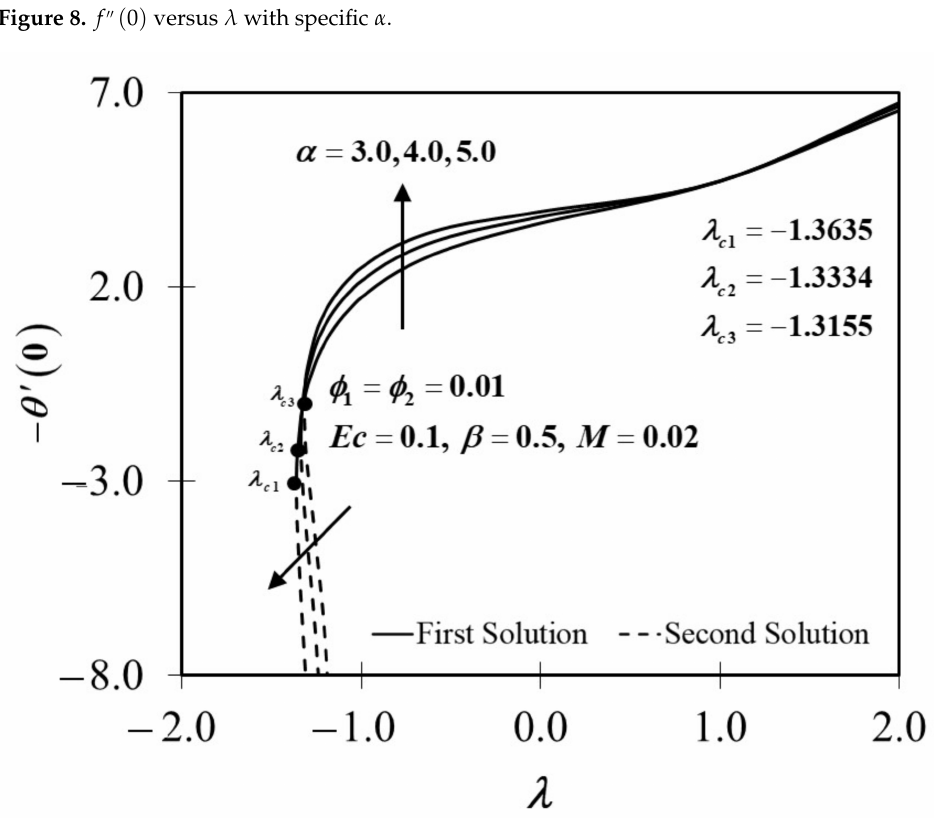
Figure 9. − θ (cid:48) ( 0 ) versus λ with specific α